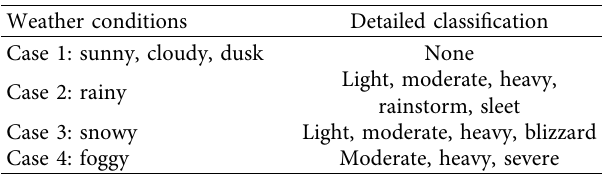
Table 2: Classification of